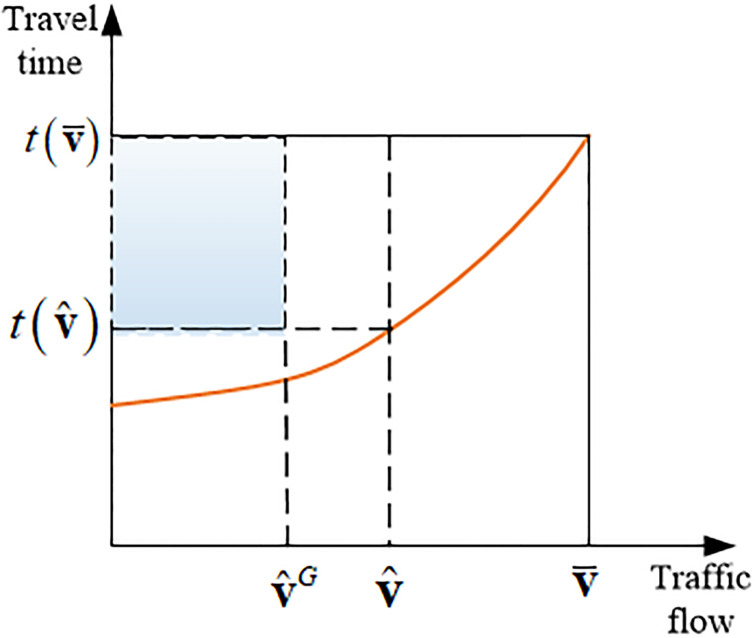
Geometric illustration of the definition of γa.